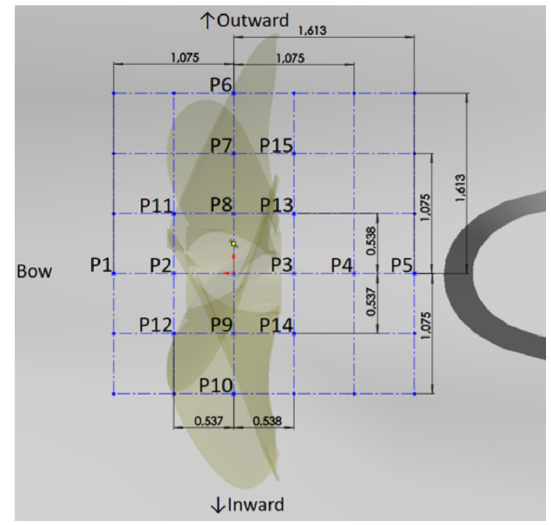
Figure 10. ProNoVi target case. Locations of the acoustic observers on the hull with respect to the propeller and the headbox of the unit in full scale.